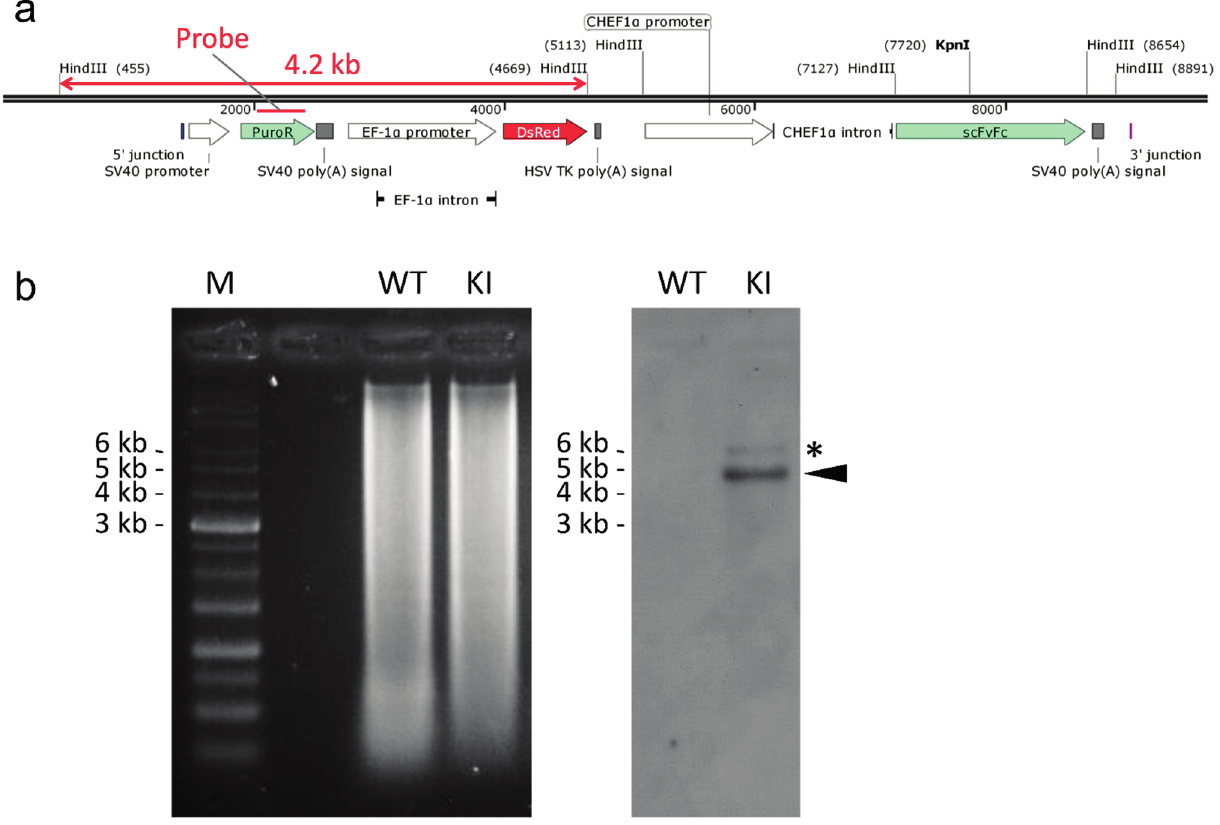
Figure 6. Southern blot analysis. ( a ) Schematic illustration of knocked-in allele. The genomic sequence after backbone-free integration is shown. The map was visualized using a SnapGene Viewer software; ( b ) The gel image ( left panel) and chemiluminescent image ( right panel) of Southern blot analysis. An arrowhead indicates the expected position of the knock-in fragment. An asterisk shows a minor band. M, 1 kb DNA Ladder (Bio Regenerations, Yokohama, Japan). WT, wild type. KI, knock-in